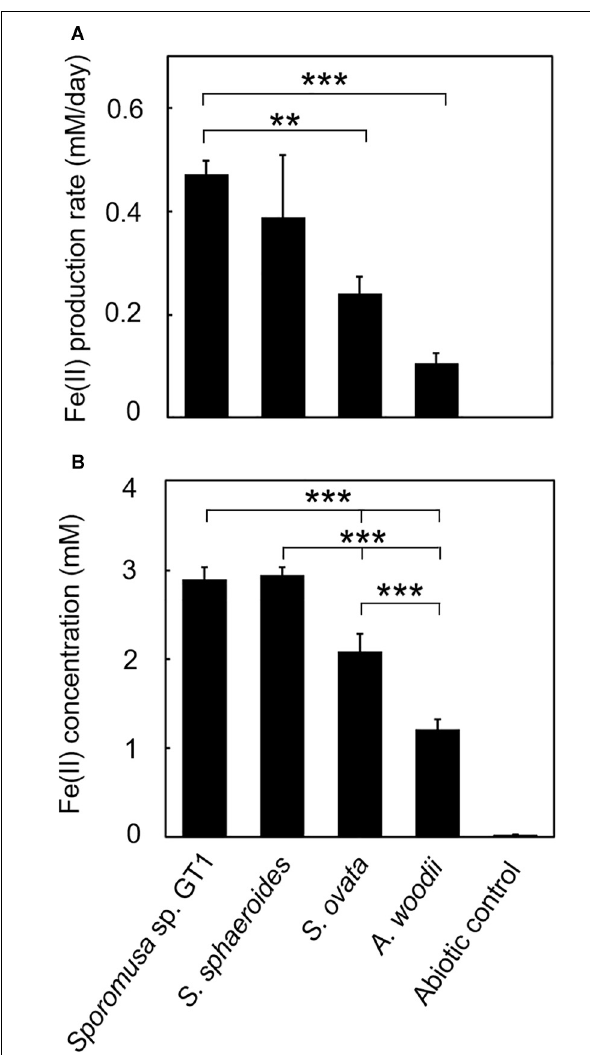
FIGURE 3 | Difference in HFO reduction activity among homoacetogens under organotrophic growth conditions. Homoacetogens were cultivated on ethanol (20 mM) in the presence of HFO. (A) Fe(II) production rate in the exponential phase. (B) Fe(II) accumulation in the stationary phase. Data are presented as the means of three independent cultures, and error bars represent standard deviations. *** p < 0.001, ** p < 0.01, determined by one-way analysis of variance with Tukey’s honest significance difference test.